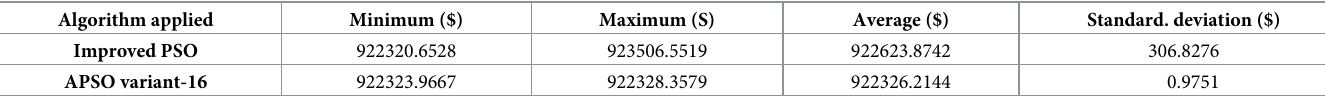
Table 3. Comparison of cost obtained from APSO variant-16 and Improved PSO. Algorithm